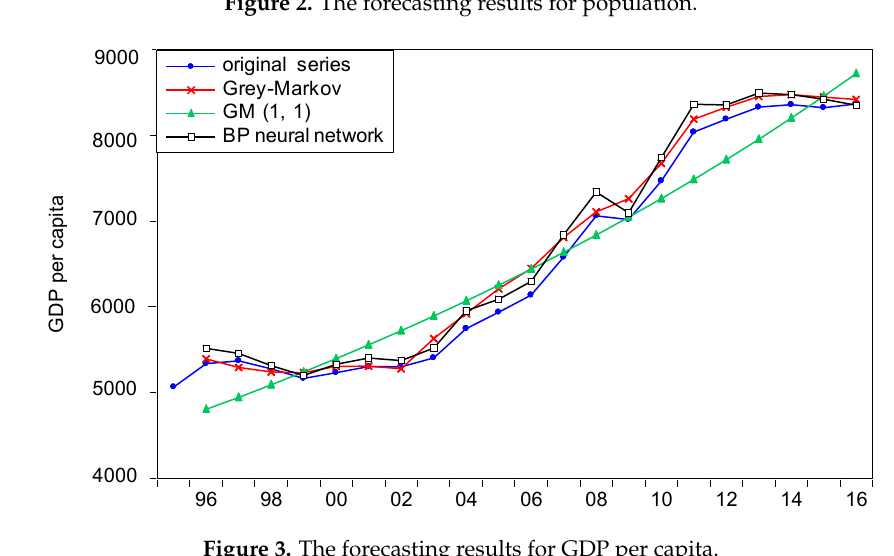
Figure 3. The forecasting results for GDP per capita.